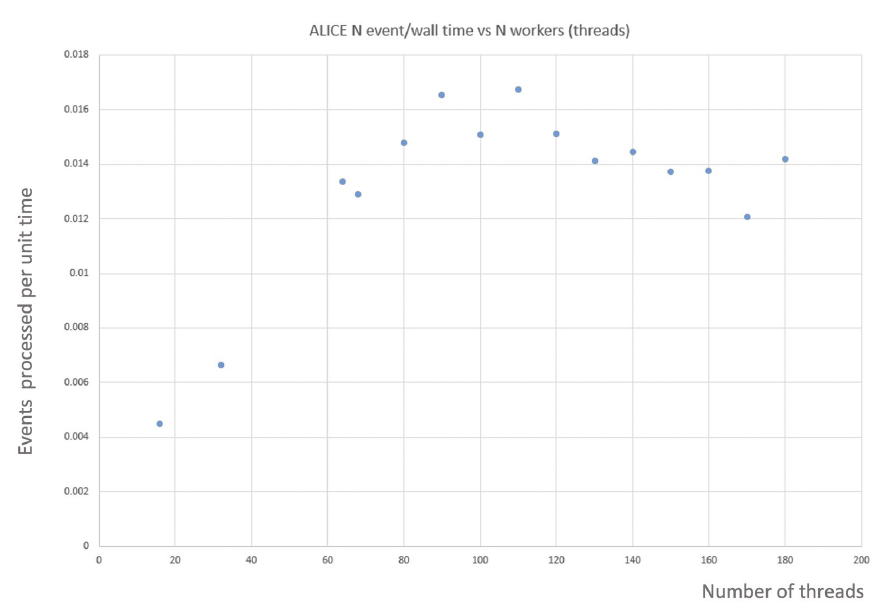
Fig. 1. Performance (as events produced per unit time) of a KNL node as a function of the number of ​